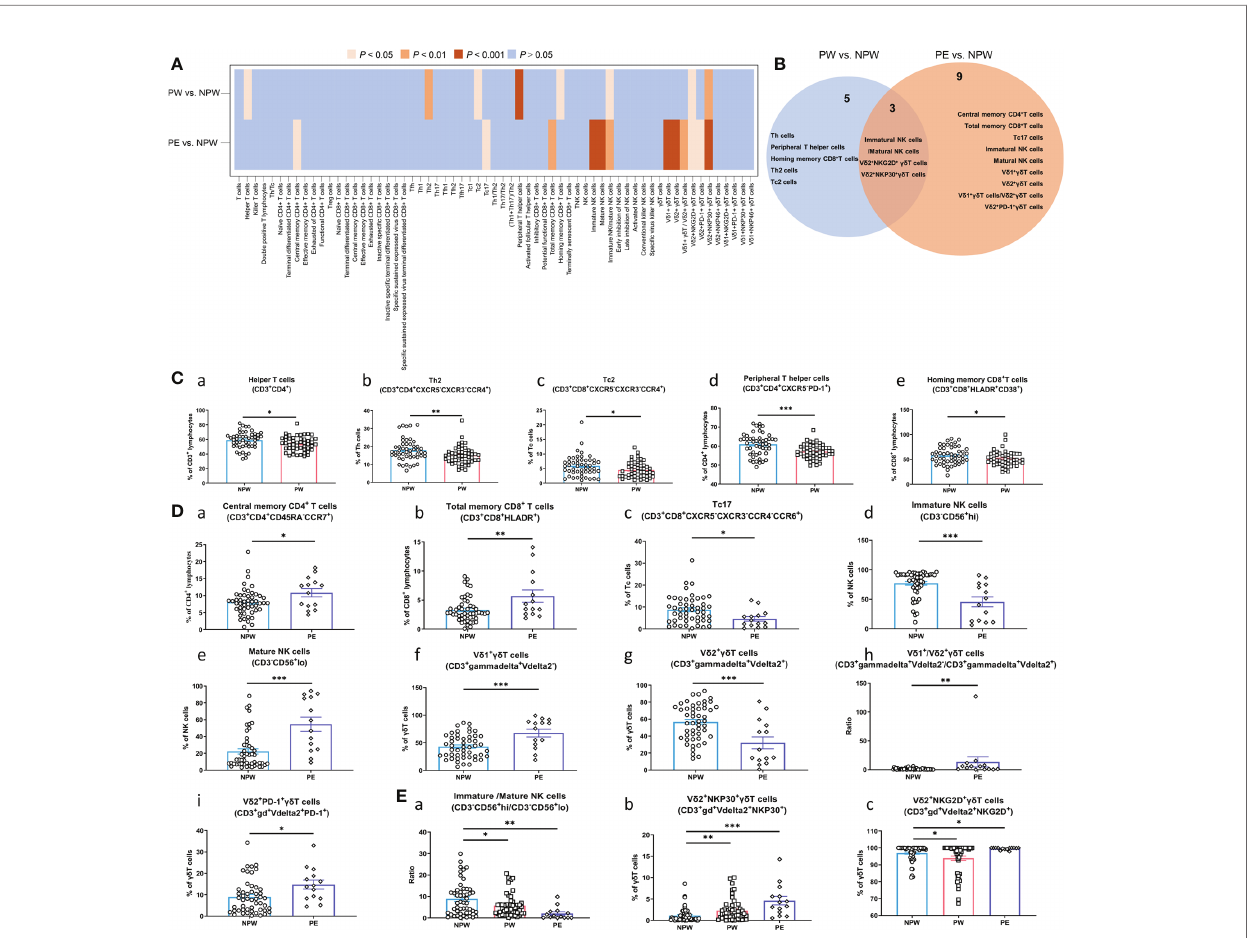
FIGURE 2 | Immune modi fi cations after normal or abnormal pregnancies. Lymphocyte composition and immunophenotypic characterization of T cells, NK cells and gd T cells in the NPW (n = 50), PW (n = 50) and PE (n = 14) groups were analyzed by multiparameter fl ow cytometry. (A) Heatmap showing the comparison of 63 immune parameters of T cells, NK cells and gd T cells in the PW and PE groups compared with the NPW group; (B) Venn diagram showing both unique and overlapping modi fi ed immune parameters in the PW and PE groups compared with the NPW group. (C) Changed immune cell subsets in women who experienced normal pregnancies (a – e) ; (D) Changed immune cell subsets in women who experienced pregnancies complicated by PE (a – i) ; (E) Common changed immune cell subsets in women who experienced pregnancy [normal (PW) or abnormal (PE)]. The Mann – Whitney U test was used to determine signi fi cant differences between the PW or PE groups and the NPW group (a – c) . All the data are shown as the mean ± SEM; * P < 0.05; ** P < 0.01; *** P <